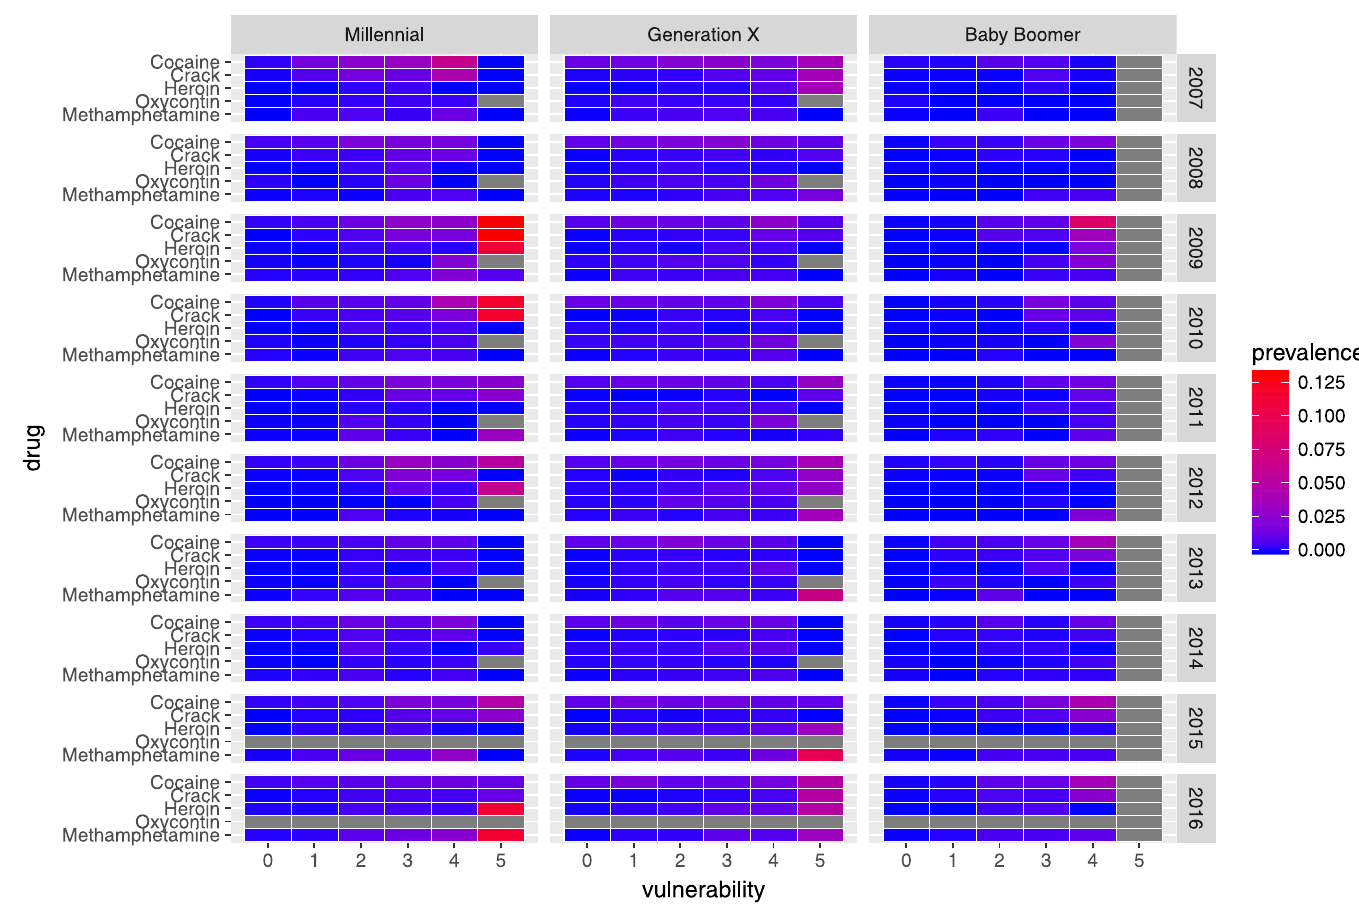
Fig 3. Patterns in prevalence of substance use by generational cohort and vulnerability, 2007–16. Grey cells denote missing data.